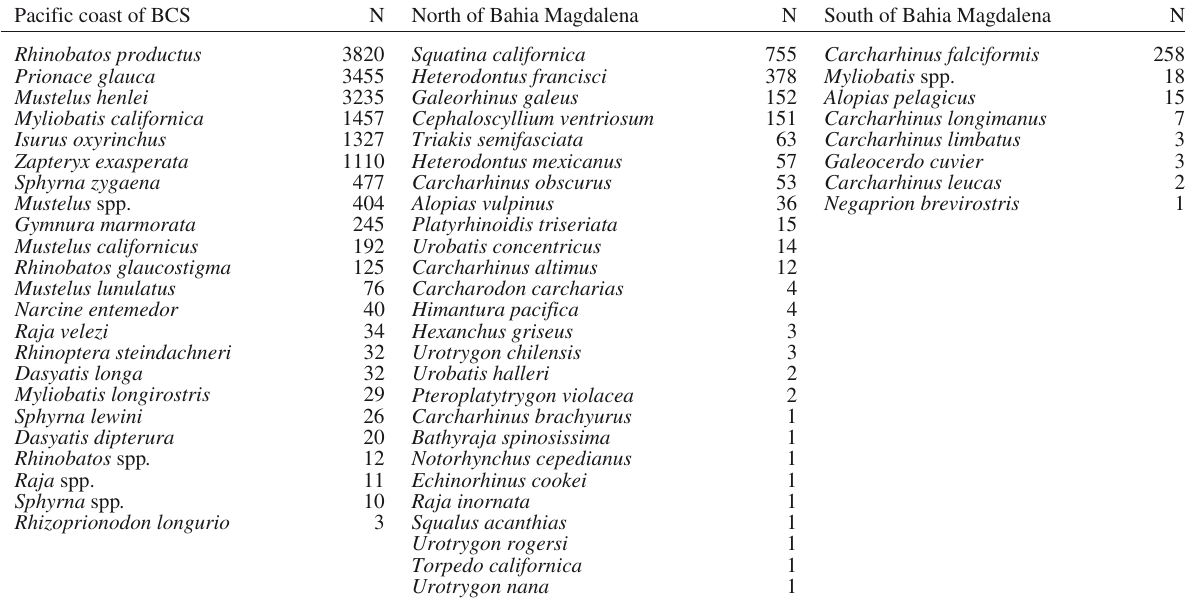
Table 8. – Arrangement of species according to marine province divisions. The first column represents species distributed along the entire Pacific coast of BCS. The “North of Bahia Magdalena” column represents species restricted to the California Province. The “South of Bahia Magdalena” represents species restricted to the Cortez Province. Species are arranged from highest to lowest relative abundance. Pacific coast of